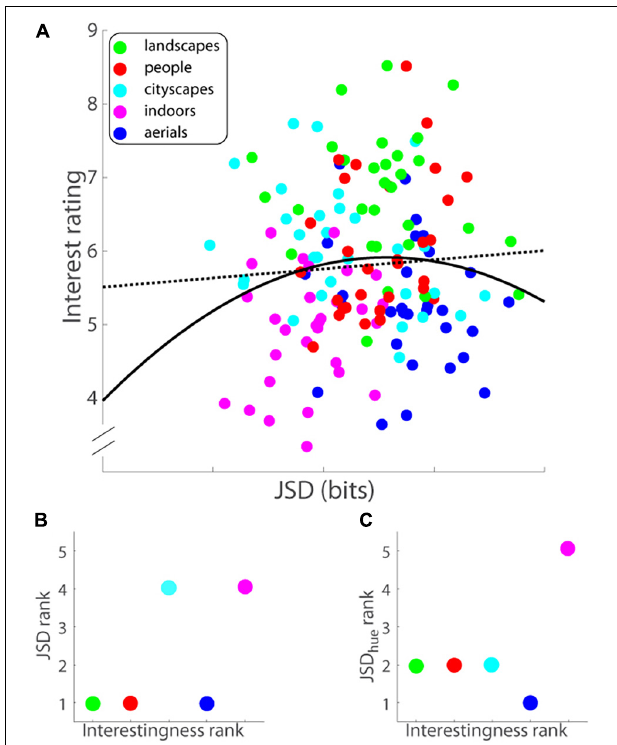
FIGURE 5 | (A) Interest rating on a ten-point scale (ordinate) versus image complexity or Jensen-Shannon divergence in bits (abscissa) for each image (Experiment 1). Data were fitted with least-squares optimal quadratic (solid black line) and linear (dotted black line) functions. (B) JSD rank of image category (ordinate) versus rank of category interestingness (abscissa). JSDs were computed of RGB formatted images. (C) JSD hue rank of image category (ordinate) versus rank of category interestingness (abscissa). RGB images were converted into HSV format and JSDs were then computed of the H (hue) component of the